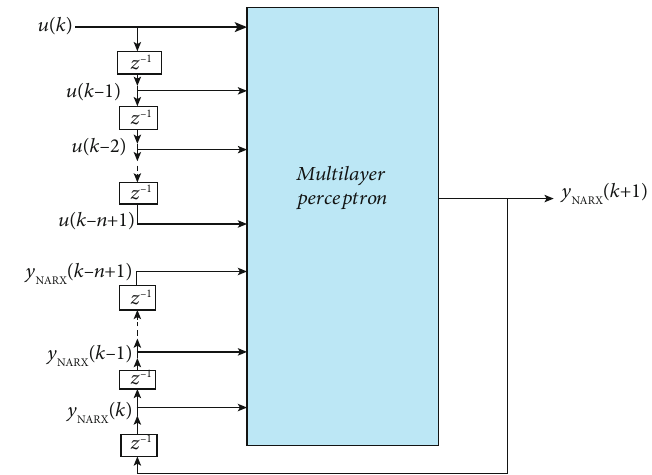
Figure 2: Nonlinear autoregressive with exogenous input (NARX) model.